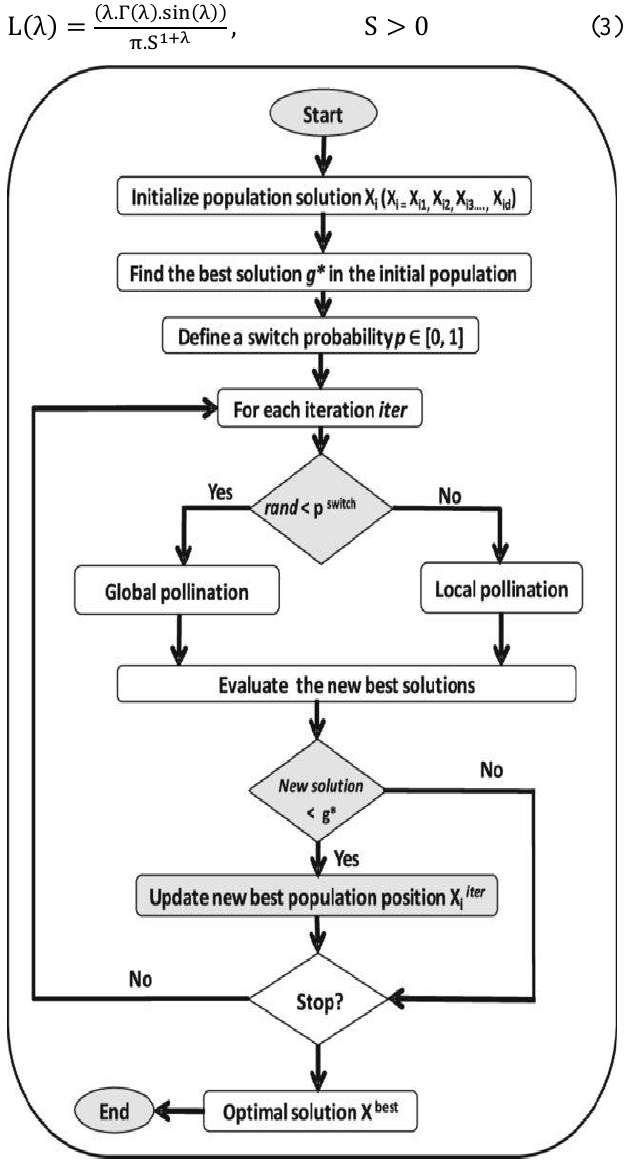
Fig. 3. Flowchart of the flower pollination algorithm [19] Where S represents the step size and Γ(λ) represents gamma function ( λ is set at 1.5, its range is 1-2). Further, the algorithm is triggered due to the change in weather, that is detected by observing the thresholds, set by the experimental trials performed in [19], for the change in voltage and current (dV and dI) shown in the Eq. 4, and Eq. 5 respectively. The thresholds vary with the size of the PV system. The value calculated by the hit and trial method for the change in voltage and current to detect the change in weather conditions are 0.2 V and 0.1amperes